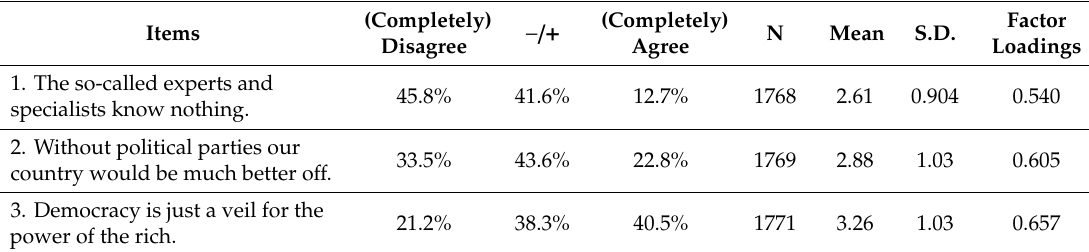
Table 3. Item wordings and descriptors of attitude items “antidemocracy”.